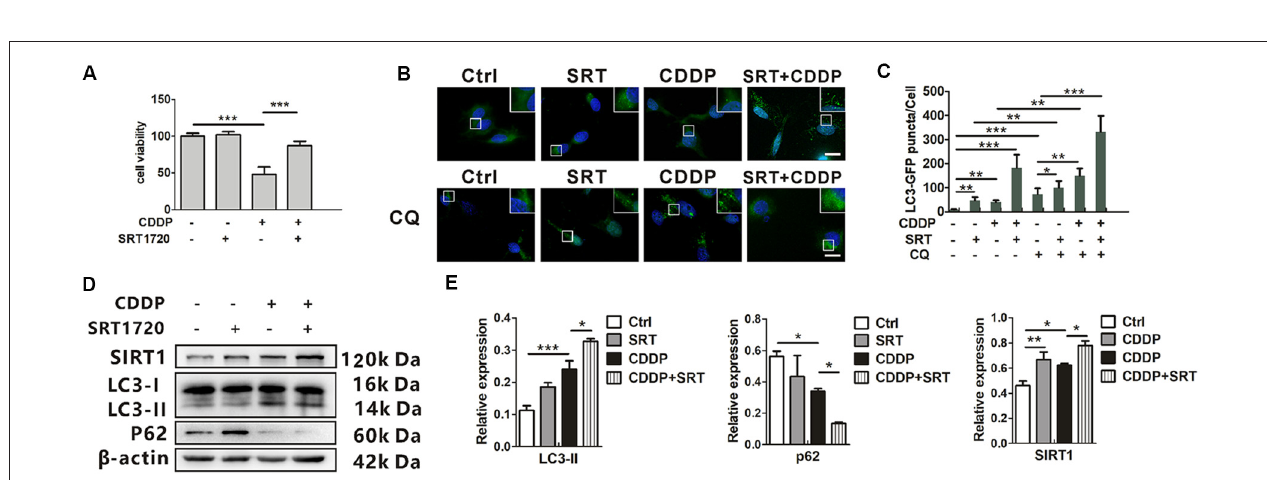
FIGURE 3 | SIRT1 activates autophagy and promotes HEI-OC1 cell survival after cisplatin-induced damage. (A) The CCK8 assay was performed to examine cell viability of HEI-OC1 cells following CDDP (20 µ M) exposure for 24 h with or without SRT1720 pre-treatment for 24 h (0.5 µ M; n = 3 individual experiments). (B,C) The fluorescence image of green fluorescent protein (GFP)-LC3 HEI-OC1 cells after CDDP (20 µ M) exposure with or without SRT1720 (0.5 µ M) and CQ (10 µ M). Scale bar, 10 µ m. Quantity analysis of green puncta was detected in five cells/experiment ( n = 3 individual experiments). (D,E) Western blots and densitometry analysis for SIRT1 and autophagy marker LC3-II and p62 in CDDP (20 µ M) exposure for 24 h with or without SRT1720 pre-treatment for 24 h (0.5 µ M; n = 3 individual experiments). Data represent the mean ± SEM. ∗ p < 0.05, ∗∗ p < 0.01, ∗∗∗ p < 0.001. CDDP, cisplatin; SRT, SRT1720.